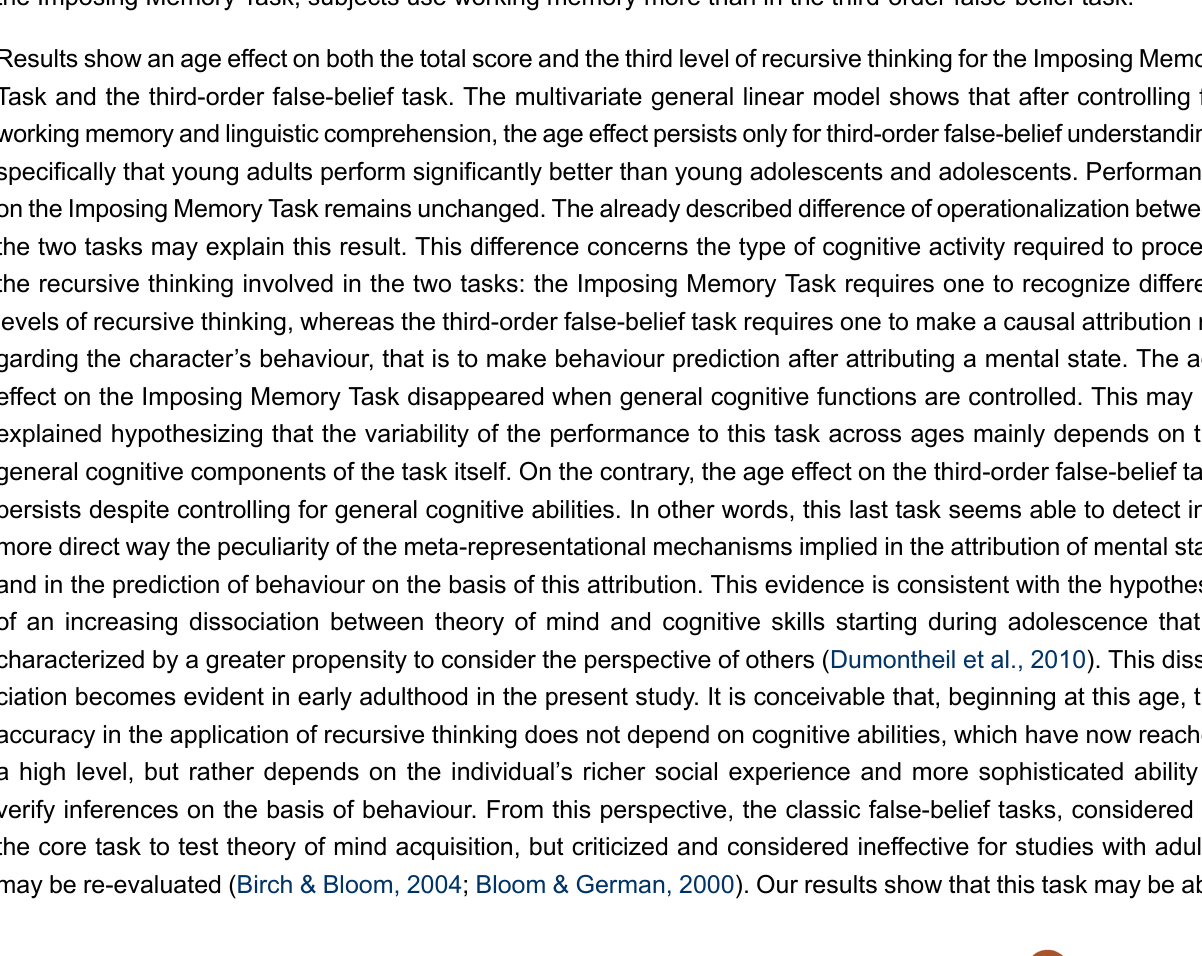
to make only one inference about the behaviour of two characters. Thus, it can be assumed that when completing the Imposing Memory Task, subjects use working memory more than in the third-order false-belief task. Results show an age effect on both the total score and the third level of recursive thinking for the Imposing Memory Task and the third-order false-belief task. The multivariate general linear model shows that after controlling